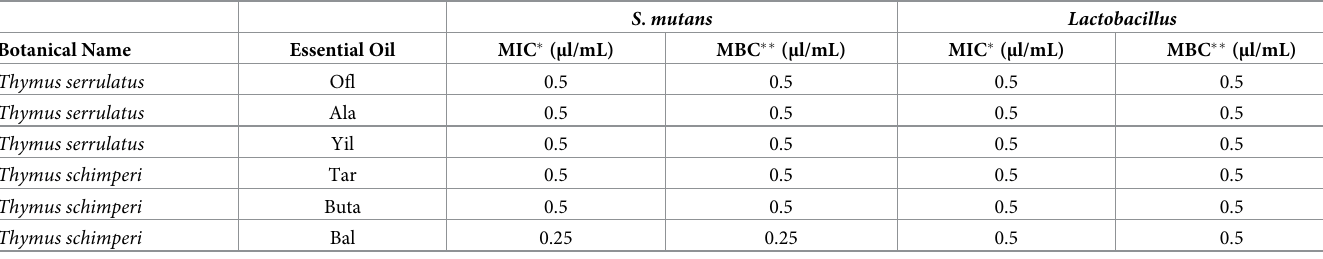
Table 3. Antibacterial activity (MIC and MBC) of Thyme EOs against S . mutans and Lactobacillus .